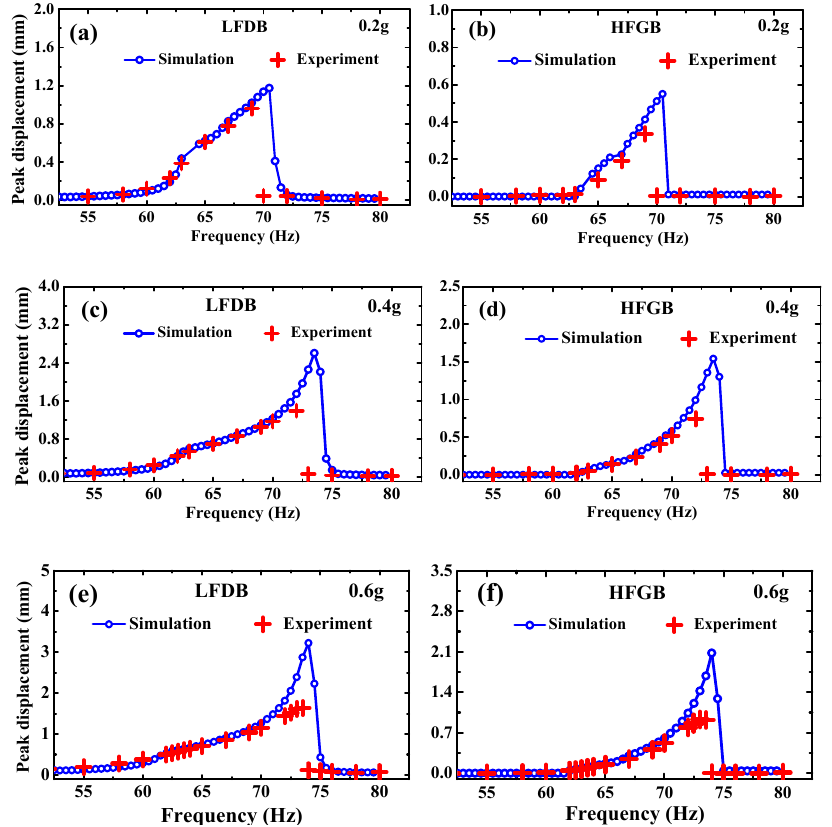
Figure 5. Experimental and simulation frequency responses of the peak displacement of LFDB with ( a ) a = 0.2 g, ( c ) a = 0.4 g and ( e ) a = 0.6 g; experimental and simulation frequency responses of the peak displacement of HFGB with ( b ) a = 0.2 g, ( d ) a = 0.4 g and ( f ) a = 0.6 g.